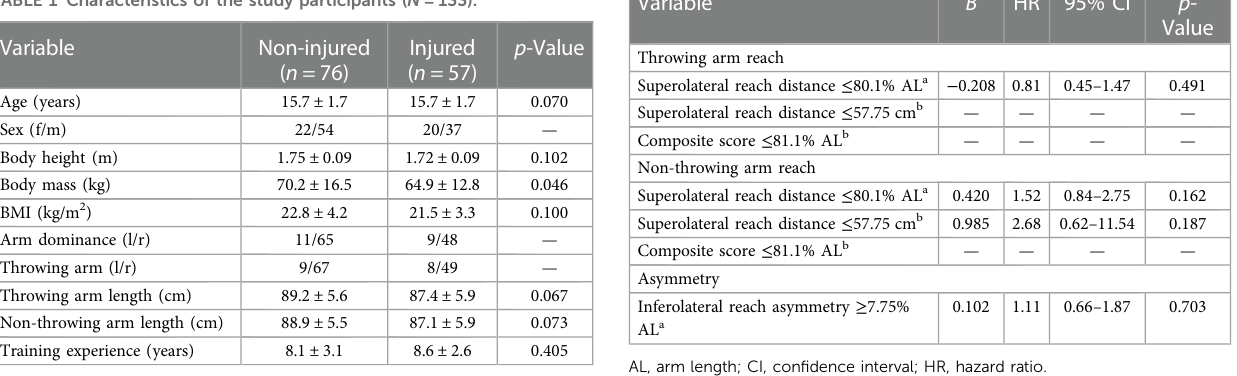
TABLE 1 Characteristics of the study participants ( N =133).